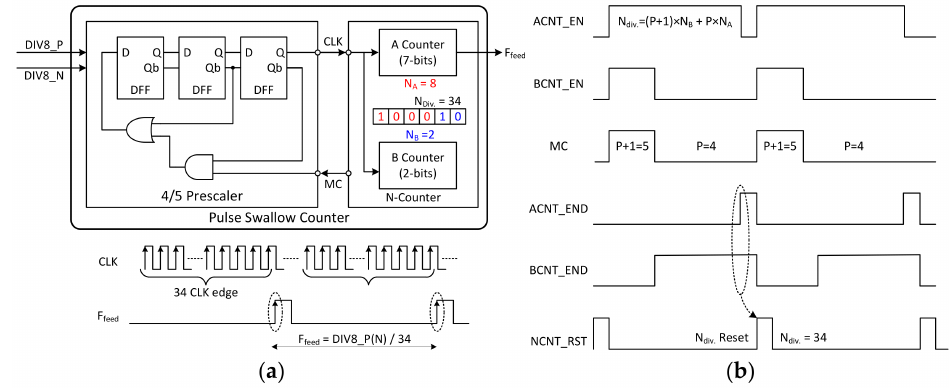
Figure 14. The ( a ) block diagram and ( b ) timing chart of the pulse swallow counter used in the frequency divider